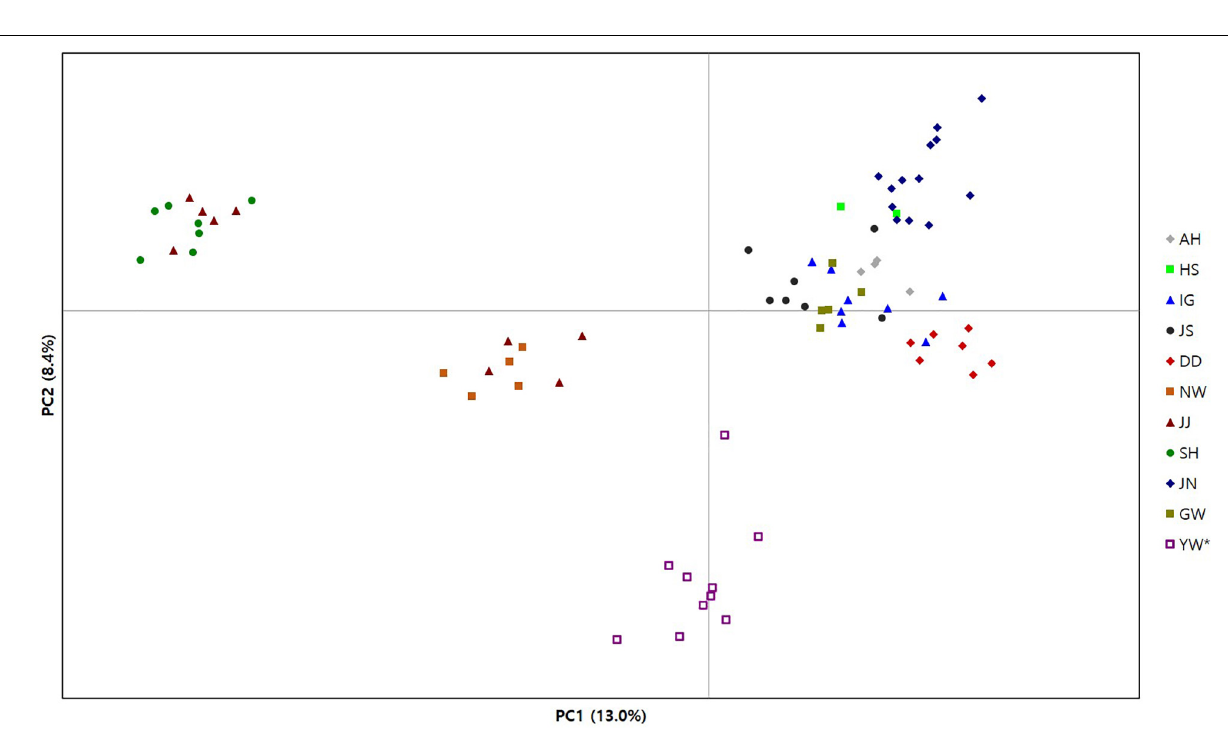
Frontiers in Plant Science |